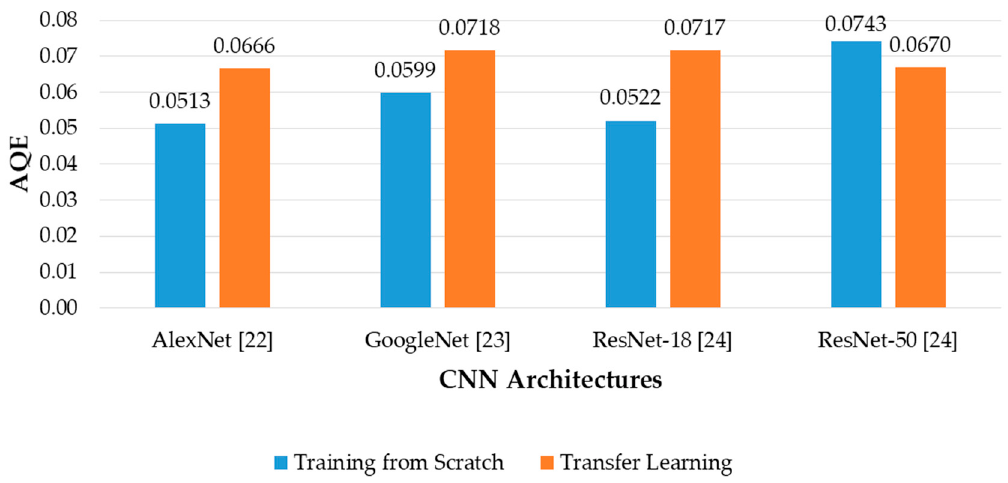
Figure 17. Adjusted average quantization error (AQE) of banknote fitness estimations using various regression CNN architectures with training from scratch and transfer learning with the differences of estimated trial values among banknotes considered.